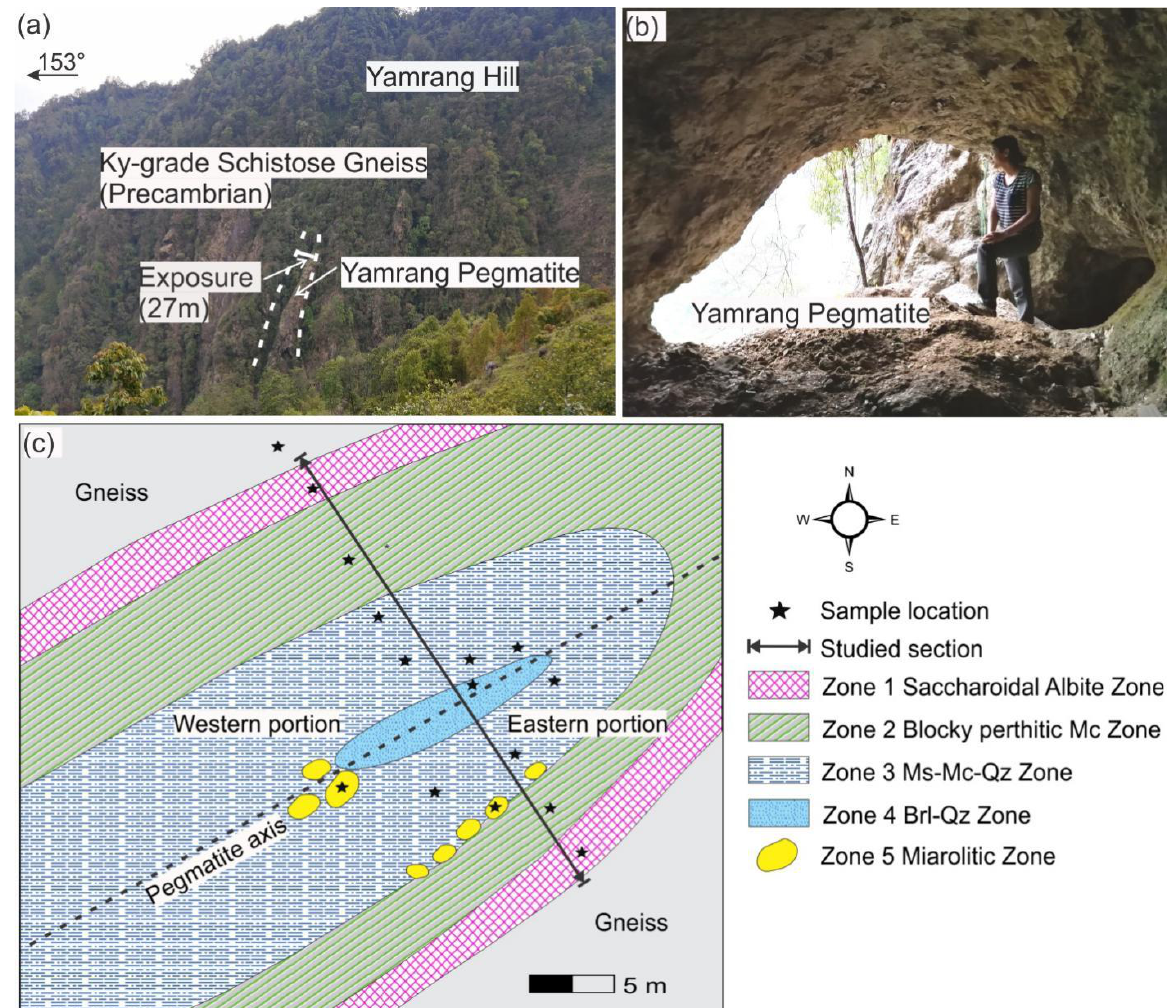
Figure 3. Field photographs and sketch map of the Yamrang Pegmatite. ( a ) Location of Yamrang Pegmatite at Yamrang hill; ( b ) Exposure of Yamrang Pegmatite, zone 3; ( c ) Schematic sketch of internal zonation of the Yamrang Pegmatite. Mineral abbreviations: Brl, beryl; Mc, microcline; Ms, muscovite; Qz, quartz. Mineral abbreviations are after [10].